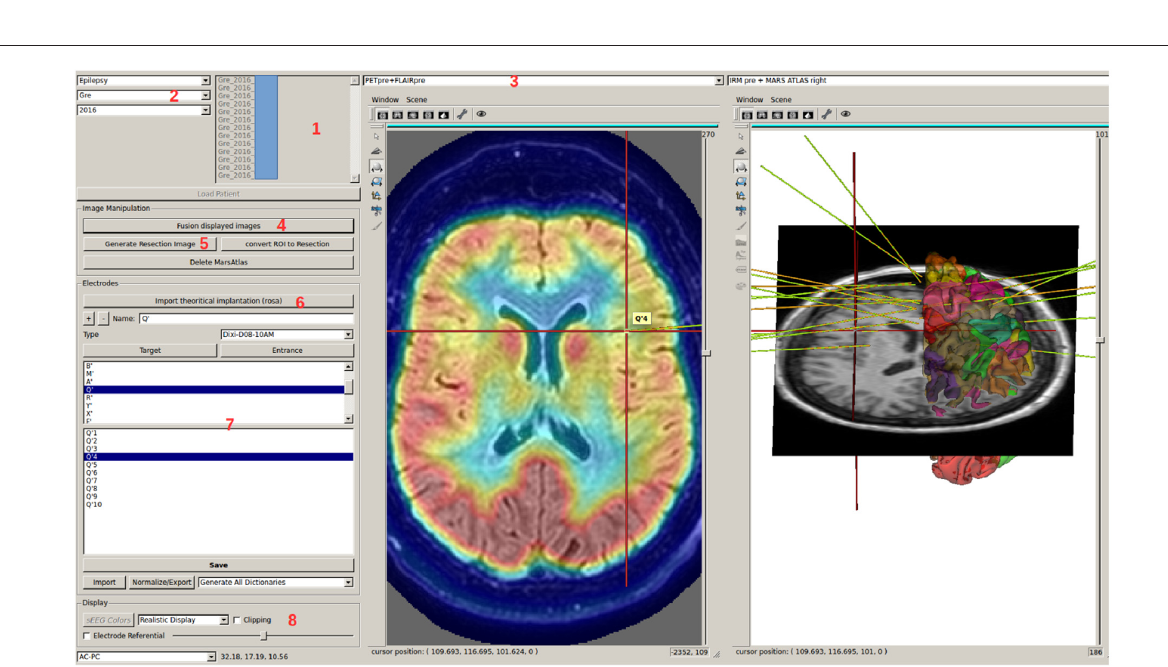
Frontiers in Neuroinformatics | www.frontiersin.org